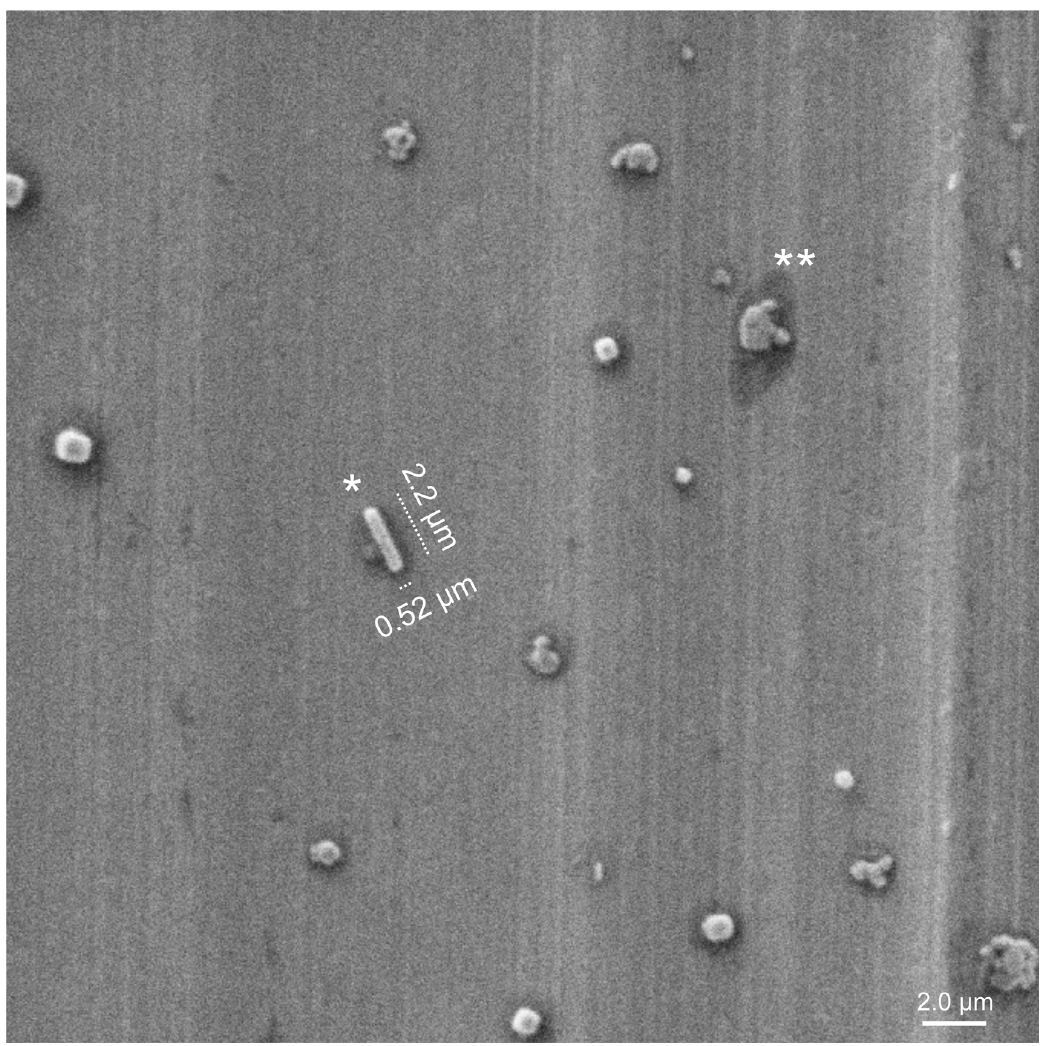
Fig 6. Isolation of Mtb from a TB patient. SEM image of patient sample impacted on the lower plate of the PM10 impactor. The dimensions and morphology of the rod-shaped structure (denoted by * ) are consistent with the presence of Mtb bacilli in the untreated TB patient. There is also evidence of multiple “ splats ” of unknown identity (one example is denoted by ** ) which might comprise organic matter derived from patient lung or respiratory tract. Note the “ halo ” structures (dark shadows) surrounding each